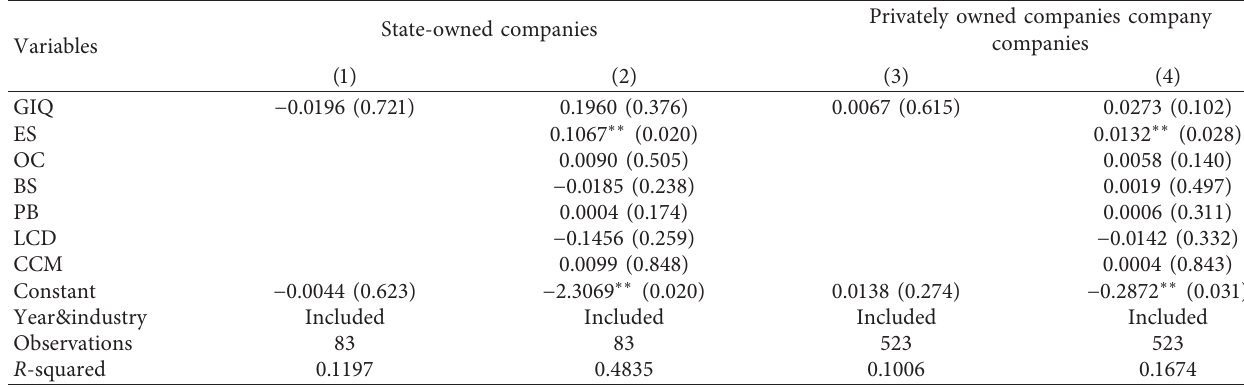
Table 11: State-owned firms versus privately owned firms: the influence of